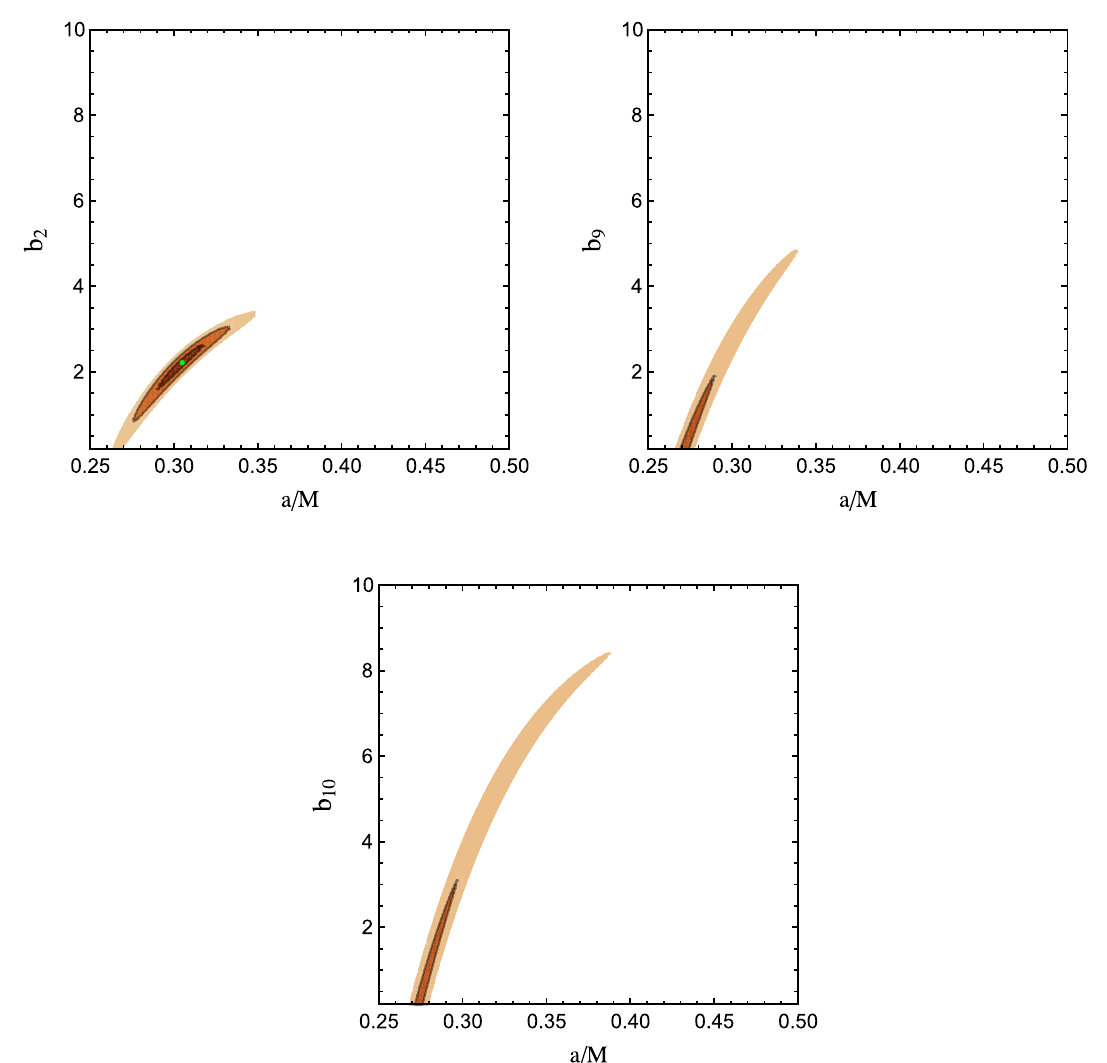
Fig. 4 Contour levels of parameters of GB metric. Contour levels for parameters b 2 (top left panel), b 4 (top right panel), b 5 (bottom left panel), b 7 (bottom right panel). The brown, orange and lighter orange are for 1 − σ , 2 − σ and 3 − σ respectively. See the text for more